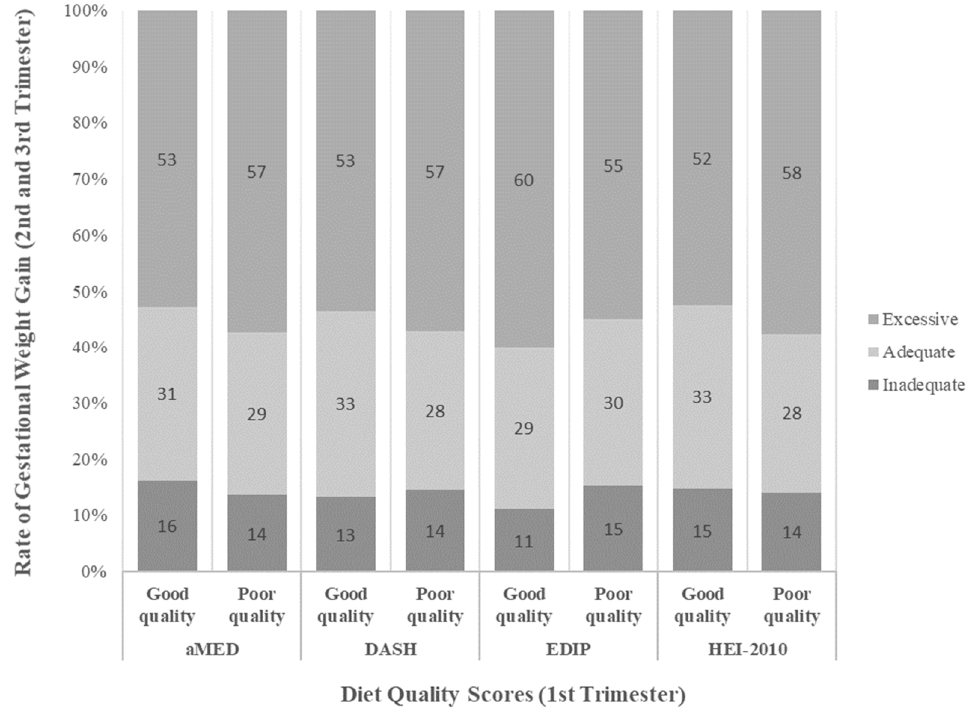
Figure 2. Proportion of inadequate, adequate, and excessive rate of gestational weight gain by diet quality defined by aMED, DASH, EDIP, and HEI-2010.